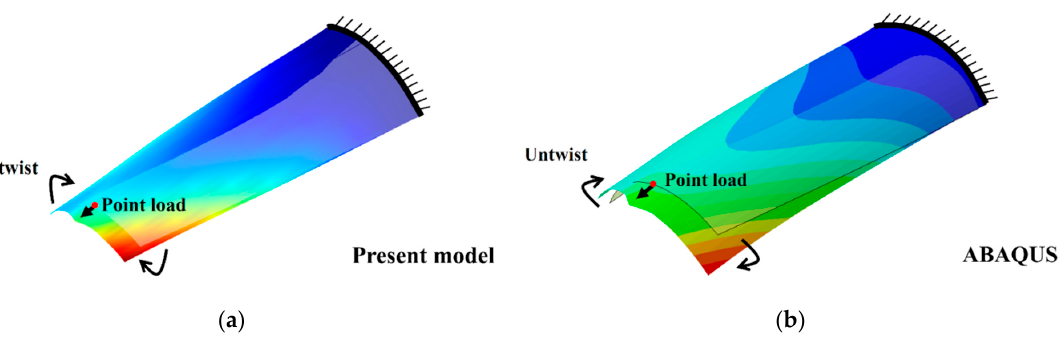
Figure 12. 3D structural configurations of a 30° pre-twisted cantilever with 90° arc profile cross sections and central point load: ( a ) present results; ( b ) ABAQUS results.